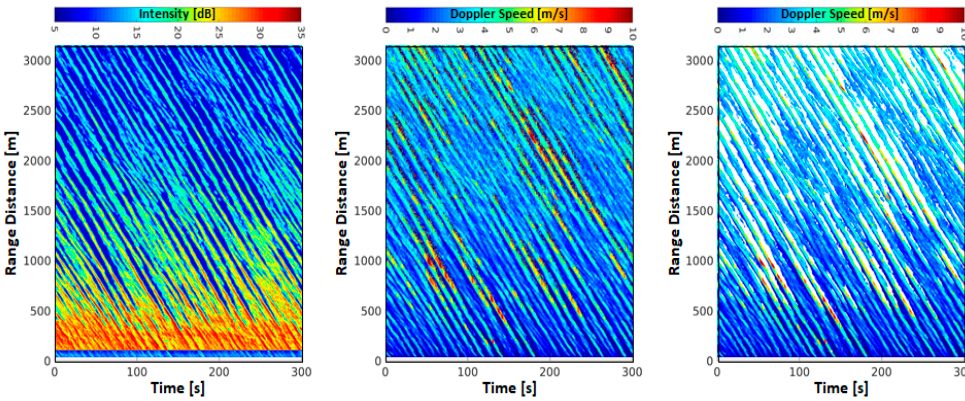
Figure 8. Radar data acquired at FINO-3 on 29 October 2017 from 12:13 UTC on for 5 min. The radar was operated in the static mode with horizontal polarization and the antenna oriented into the peak wave direction of 315°. Radar intensity ( right ), Doppler speed ( center ) and Doppler speeds with areas below a confidence level (Equation (5)) of 0.5 were masked white ( left ). Doppler speeds were retrieved using a 1000 pulses corresponding to 0.5 s.